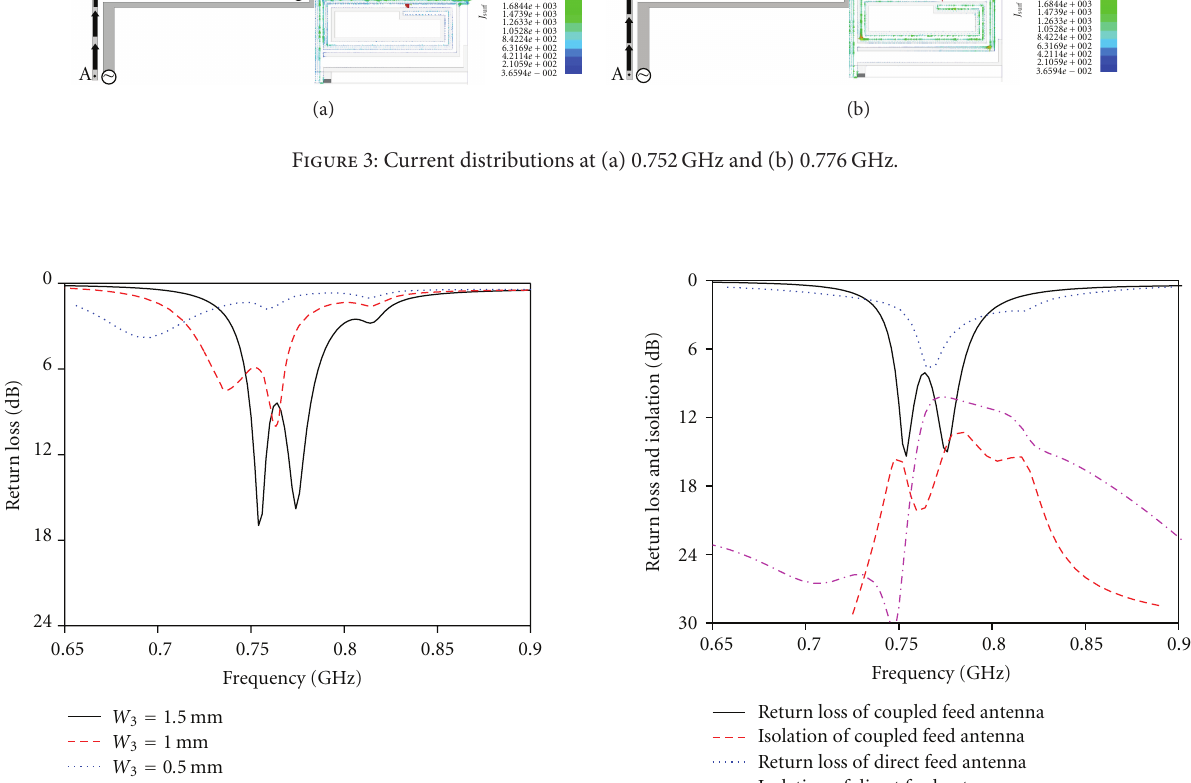
Figure 6: Return loss and isolation characteristics of the proposed main folded monopole element with either a coupled feed structure or a direct feed